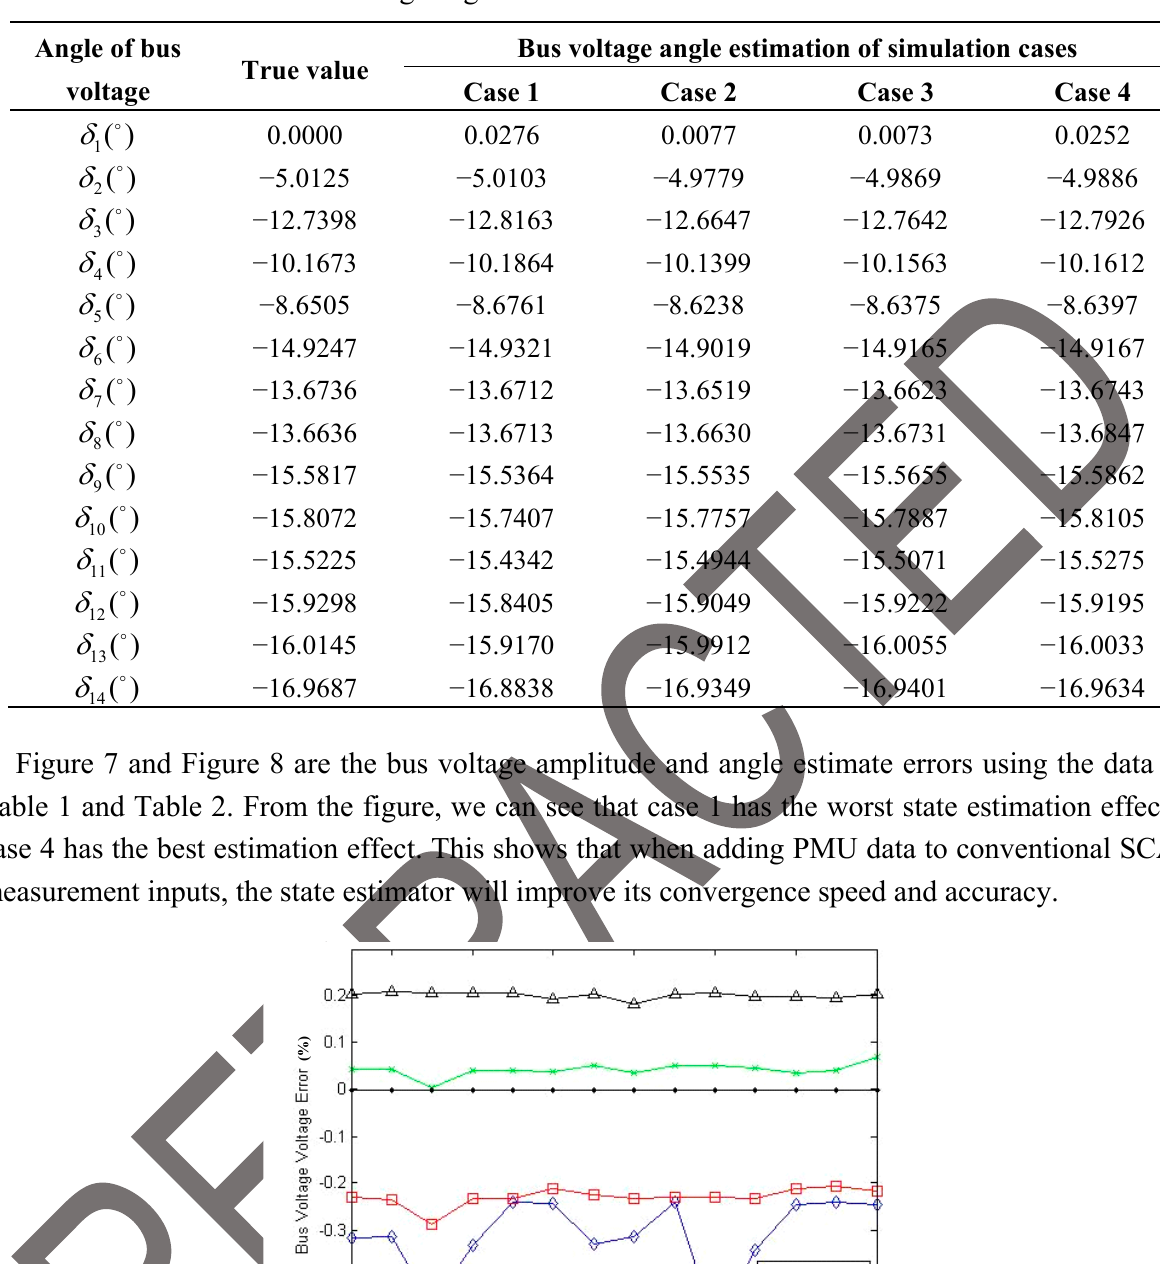
Table 3. Bus voltage angle estimation of the cases used in simulations.